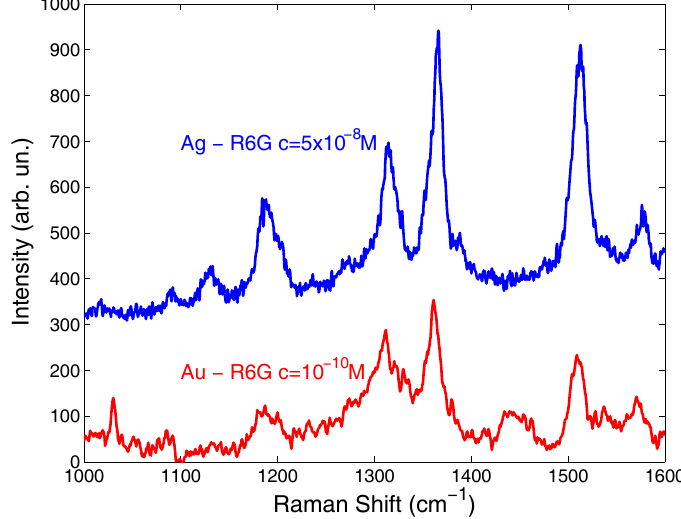
Figure 7. Raman spectra acquired on silver and gold nanostructured substrates soaked in aqueous solutions of R6G at concentrations c = 5 × 10 − 8 and c = 10 − 10 M